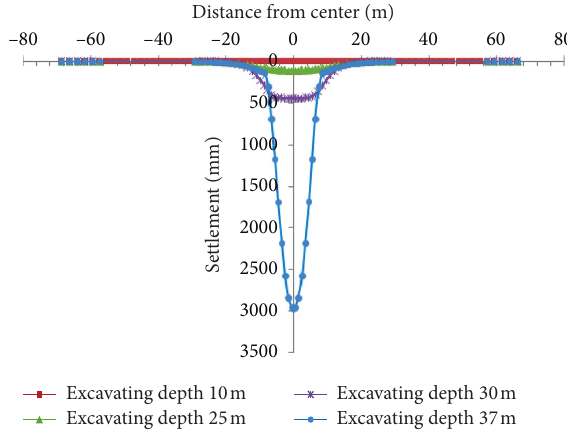
Figure 28: Tunnel vault settlement during excavation.